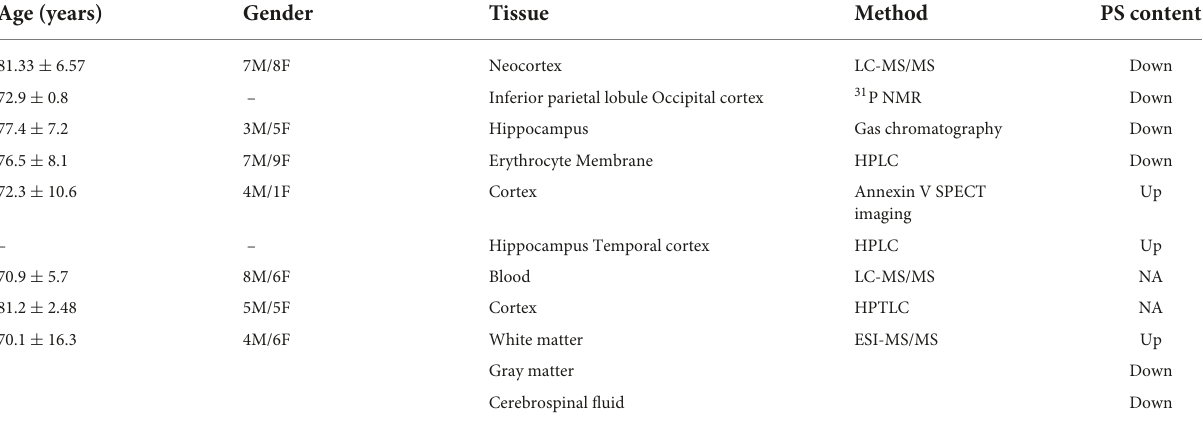
TABLE 2 The alteration of phosphatidylserine (PS) in Alzheimer’s disease (AD) patients. Age (years)